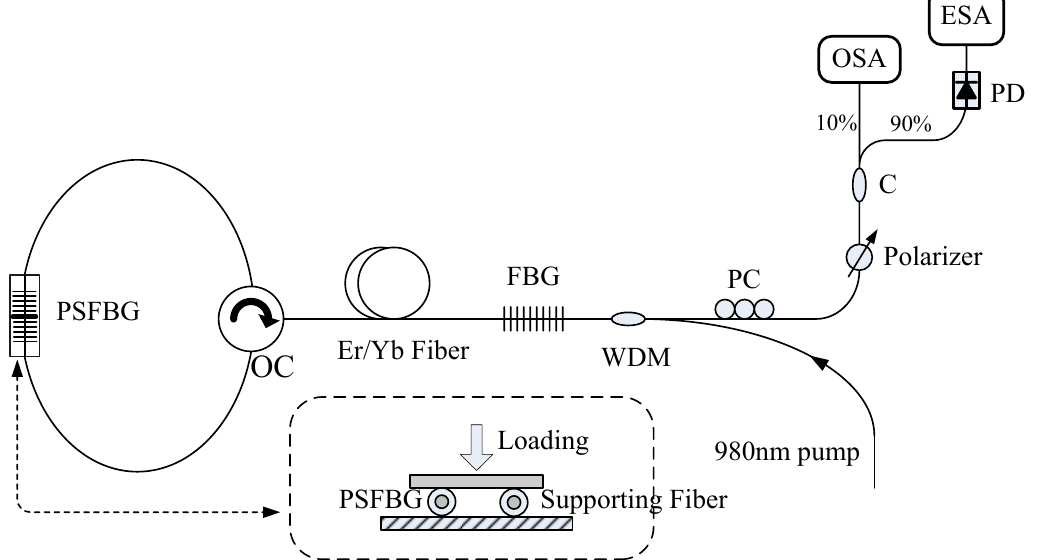
Figure 21. The schematic diagram of the PSFBG based dual-wavelength laser and the microwave generation; inset is the transversal loading configuration. Optical circulator: OC; polarization controller: PC; coupler C; photo-detector: PD; electrical spectrum analyzer: